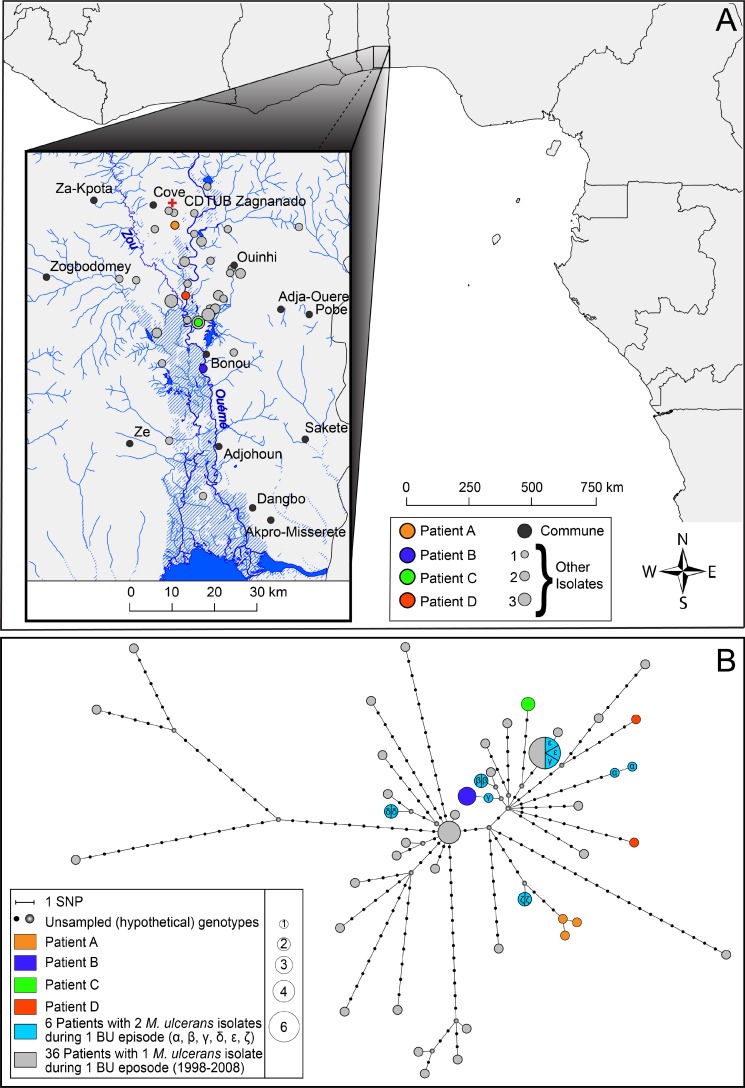
A: Geographical origin of the 58 isolates included in the study.Patients of special interest are colored accordingly. The size of the dots is proportional to the number of patients originating from a specific village varying from 1 to 3. The Ouémé river and its tributaries, and the BU treatment center of Zagnanado are shown as well. B: Median-Joining network showing patterns of descent among the 58 studied M. ulcerans isolates. Each circle represents a unique genotype, and the size of the circle is proportional to the number of individuals sharing that type. Every edge represents a single mutational step (or SNP) separating the sampled and hypothetical genotypes. Genotypes obtained from patients of special interest are colored accordingly.